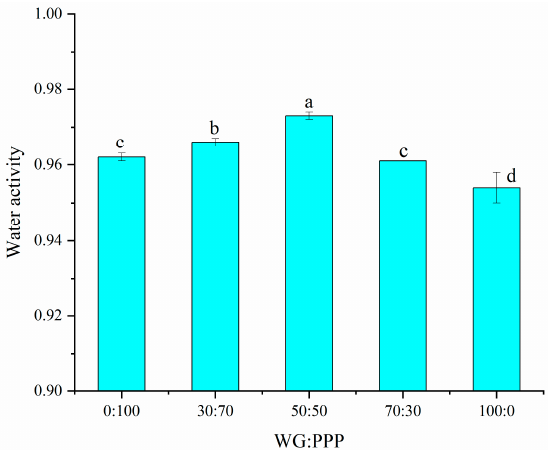
Figure 9. Water activity of extrudates with different mixing ratios. Different superscript letters mean significant differences (Duncan’s test; p < 0.05).